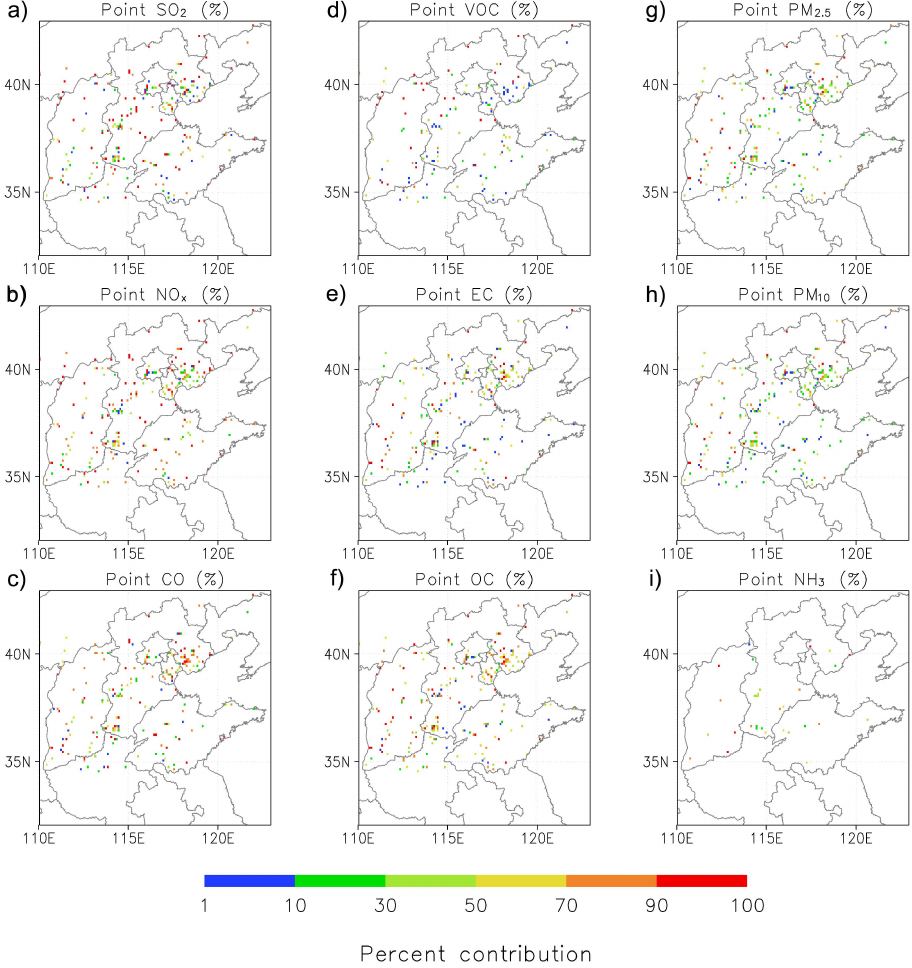
Fig. 6. Percent contributions of the point sources to the total emissions in each grid (0.1 ◦ latitude × 0.1 ◦ longitude) in Huabei for the year